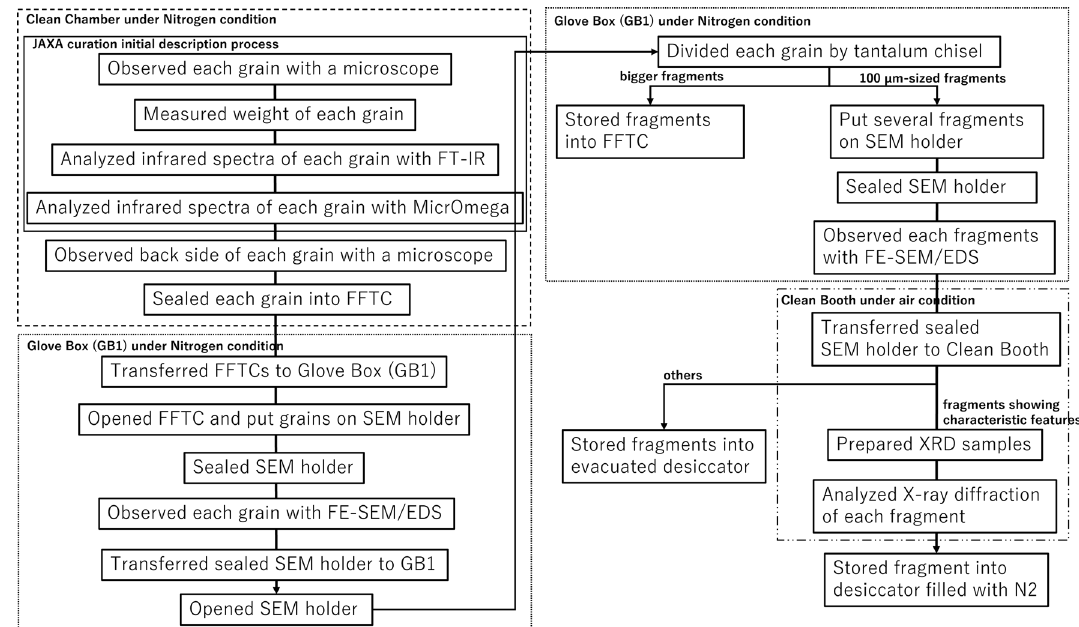
Fig. 2 Flowchart of a series of processes for JAXA‑DD samples. Note that the majority of grains have only been exposed to vacuum and nitrogen environment in clean chamber and glove box, and then have been stored under nitrogen